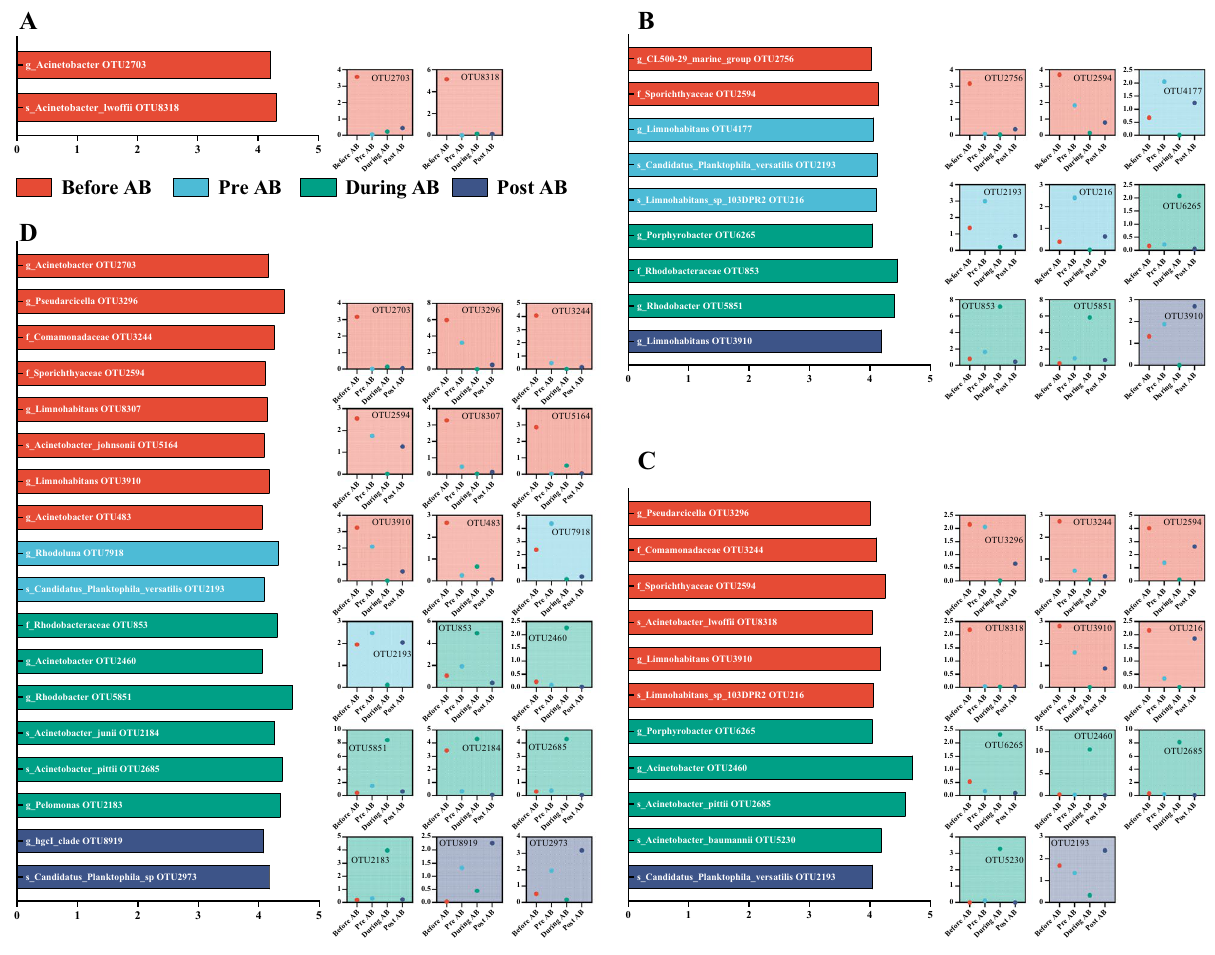
Figure 6. Significant bacterial species (OTUs) based on significant and LEfSe analyses. Figures of ( A – D ) represented HS, JFZ, SH, and XH rivers. Bar plots exhibited LDA scores of each OTU, with its clearest phylogenetic level, and the scattered dot plots illustrated the dynamic changes of each OTU’s relative abundance.